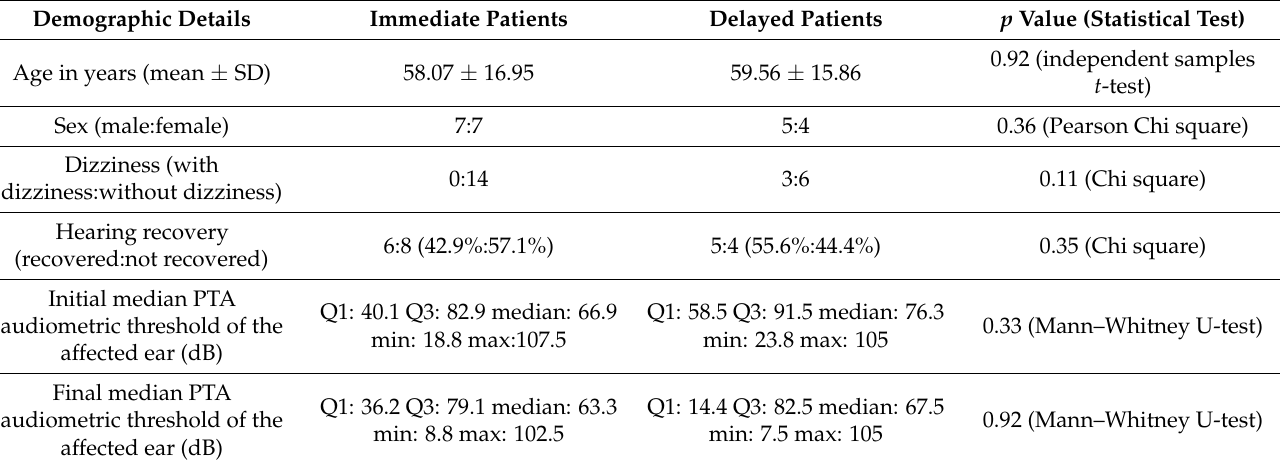
Table 2. Characterization of sudden sensorineural hearing loss (SSNHL) in immediate and delayed sampled